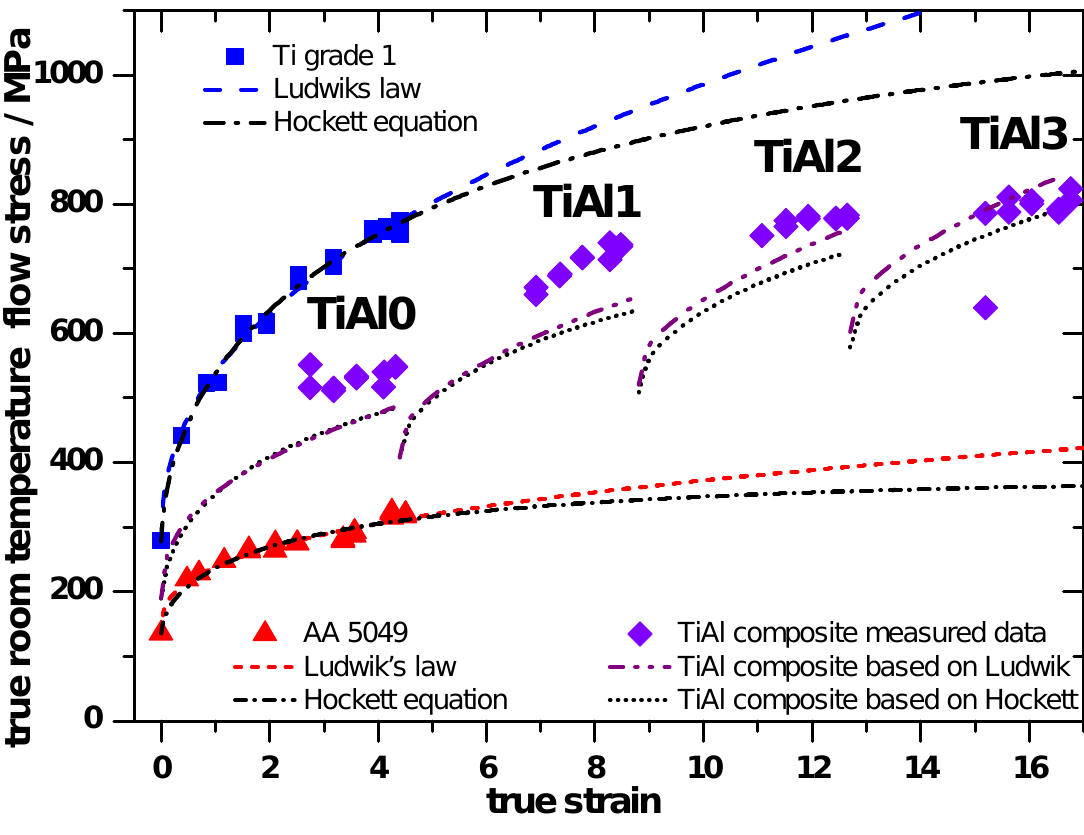
Figure 1. Flow curves of the used Ti grade 1, AA5049 alloy up to a true strain of 4.5 with fits by Ludwik’s equation, the composite made from both materials up to a true strain of 16.6 and the calculated flow curves of the composites (preserved by weighting the fitted yield stresses for Ti and the Al alloy according to their volume fraction in the